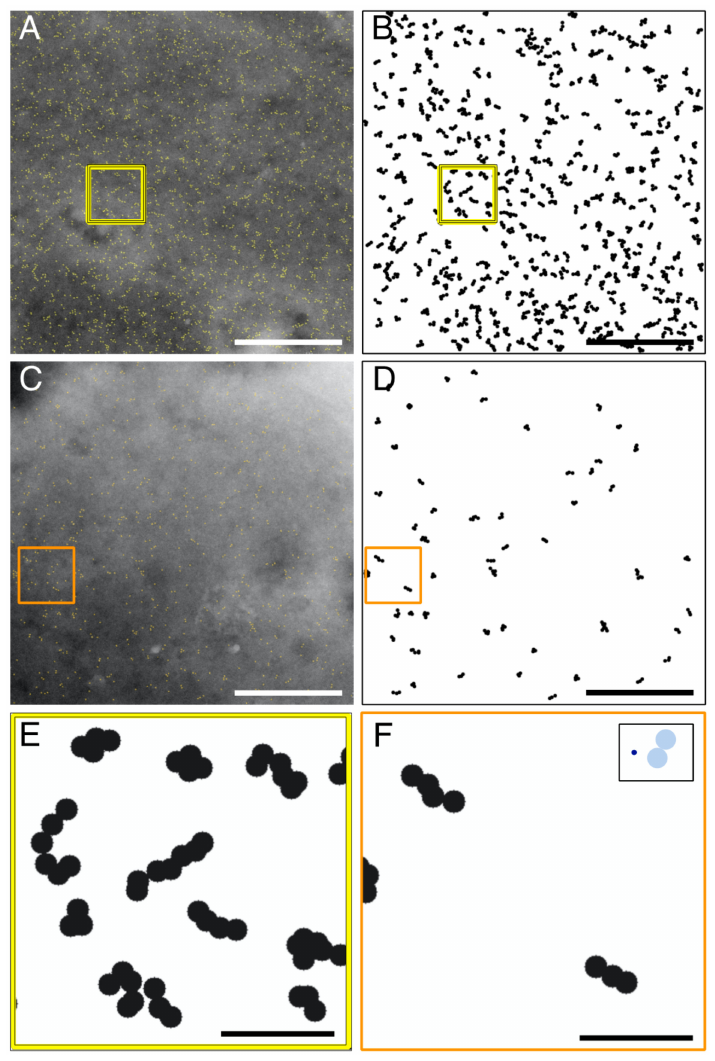
Figure 2. Scanning transmission electron microscopy (STEM) and cluster analysis of ORAI1 distri- butions in whole cells in liquid state. ( A ) Typical STEM image recorded from a resting cell with a relatively high expression of ORAI1 proteins. The electron-dense QD cores are outlined in yellow (2817 labels), revealing scattered single labels as well as many ORAI1 clusters. ( B ) Result of the cluster analysis of the image shown in ( A ), excluding single labels and dimeric labels and showing only ORAI1 clusters consisting of more than two QDs (clusters >2). The labels are drawn as black circles (radius of 17 nm from the center position of each label), each indicating the possible spatial range of the underlying QD-binding ORAI1 protein. The majority of the ORAI1 clusters display a linear or elongated shape, as can be seen in the examples in the boxed region. ( C ) Exemplary image from a cell at rest with a low density in our study (748 labels). ( D ) Cluster analysis showing all detected clusters >2 in ( C ). ( E , F ) show more detail of the elongated clusters in the boxed regions in ( B , D ), respectively. In the insert in ( F ), a dark blue circle depicts the dimension of a hexameric ORAI1 channel (7 nm extracellular diameter), two light blue circles of 35 nm diameter illustrate the space that can be maximally occupied by two labels bound to the same hexameric ORAI channel (see also Figure 1). The majority of the label clusters have major axis lengths exceeding the maximal distance of 70 nm, the limit for labels binding to the same ORAI1 hexamer, and thus indicate the presence of supramolecular assemblies of ORAI1 proteins. Scale bars in ( A – D ) = 1 µ m, in ( E , F ) = 200